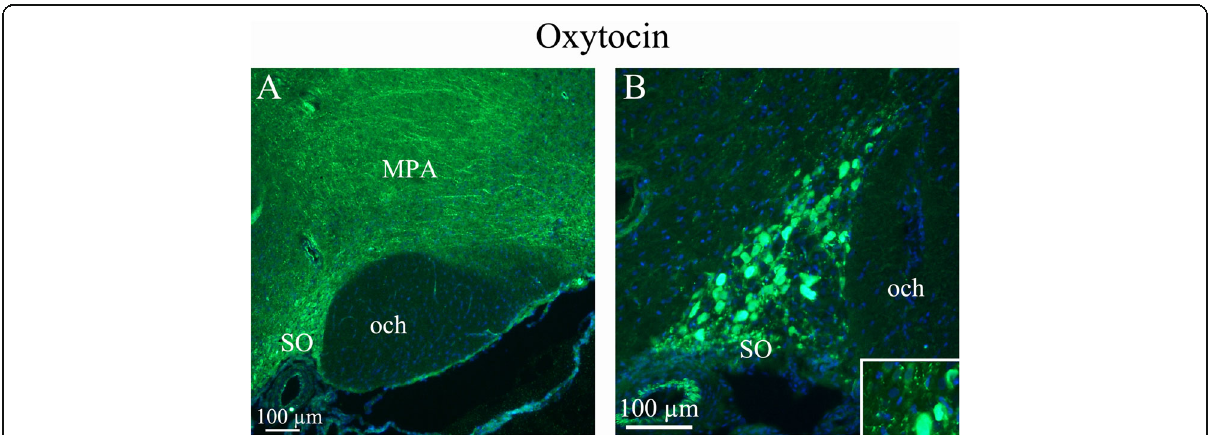
Fig. 2 Oxytocin immunohistochemistry of the supraoptic nucleus and optic chiasm. a. A and B . The image shows immunoreactive magnocellular neurons of the supraoptic nucleus (SO). The optic chiasm (och), close to the SO, shows no immunoreactivity. Immunoreactive fibers in the medial preoptic area (MPA) are seen. Insert in B: Higher magnification of stained magnocellular neurons and occasional thin